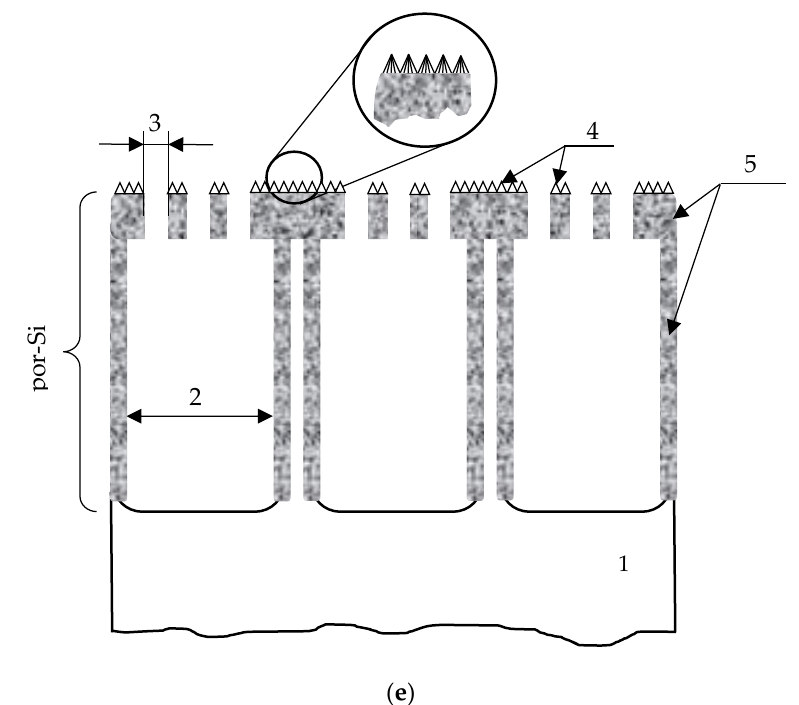
Figure 1. The microstructure of porous silicon according to ion-electron microscopy data ( a , b ) is a general view of the por-Si and surface at various magnifications (×8000 and ×15,000 times, respectively); ( c ) the view of the skin layer (presumably) over the macropore type 1; ( d ) view of the skin layer (presumably) above the skeletal part of the macroporous layer, cone-shaped porous nanostructures are visible; ( e ) a schematic representation of the sample microstructure: 1 — Si; 2 — macropore 1; 3 — macropore 2; 4 — cone-shaped nanostructures; 5 — mesoporous coating.